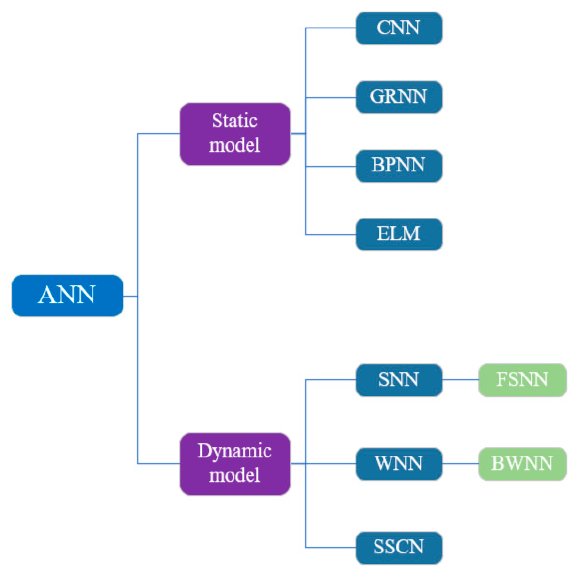
Figure 4. Nine ANN-based models for residual strength or residual life prediction.